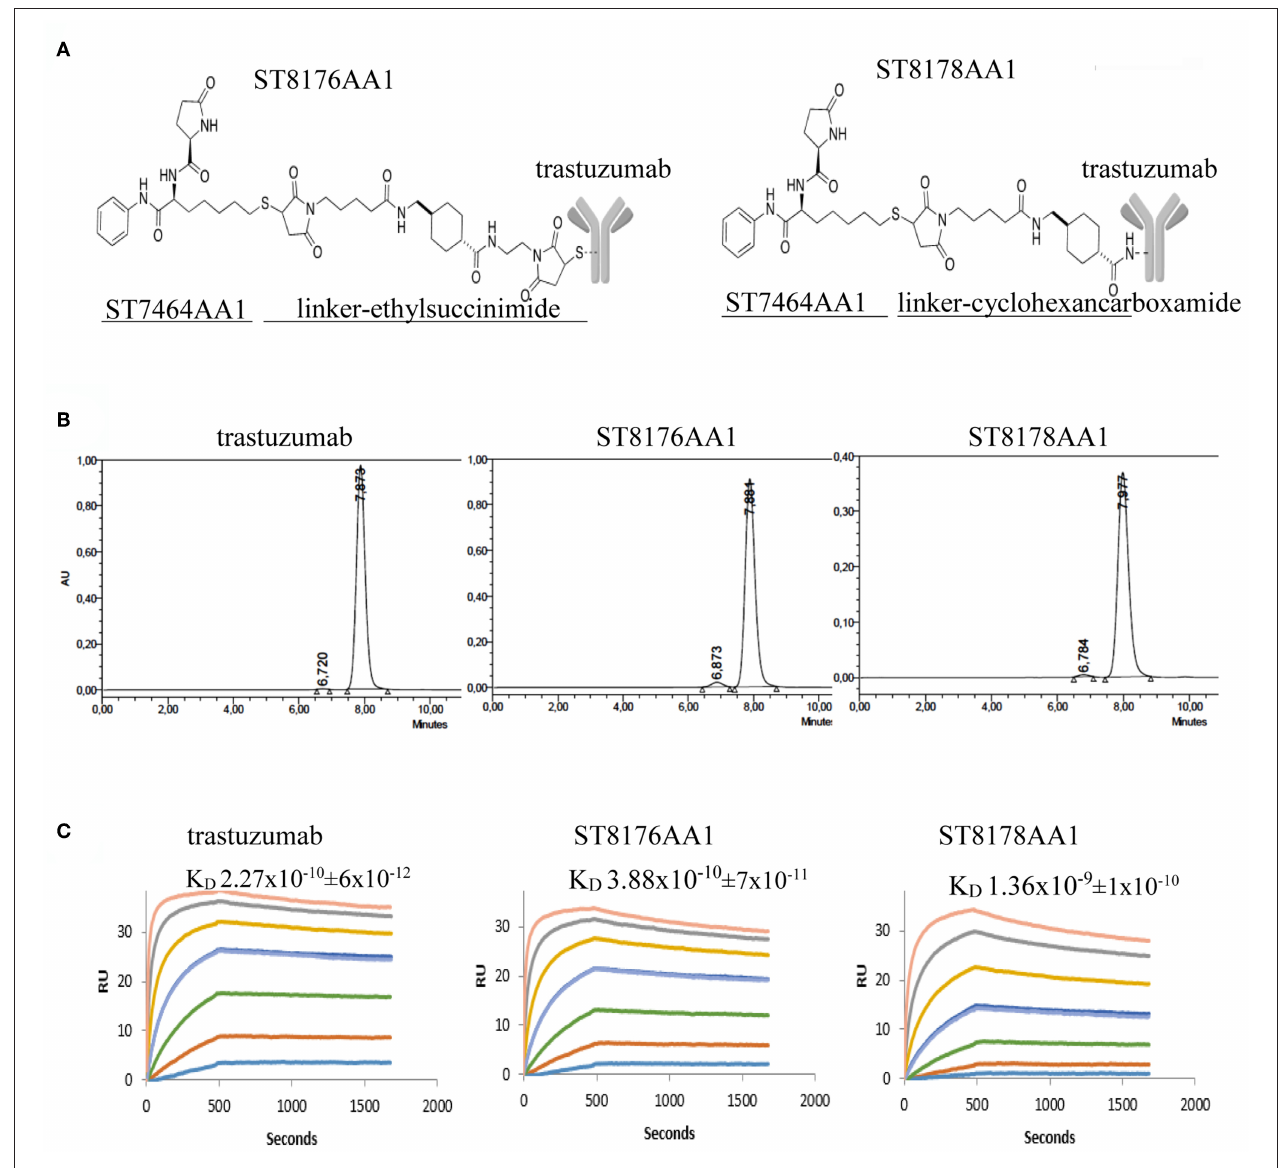
FIGURE 1 | Generation and preliminary characterization of trastuzumab-HDACi ADCs. (A) Schematic representation of ADC ST8176AA1 and ST8178AA1. (B) Size exclusion chromatography. (C) ErbB2 binding affinity by Surface Plasmonic Resonance (SPR). Analysis on BiaCore T200. Test items were flowed at 0.41–300nM concentrations. Sensorgrams fitting 1:1 model provided K D values that are reported in each graphic as mean of three independent determinations ± SD. One representative sensorgram of each test item is